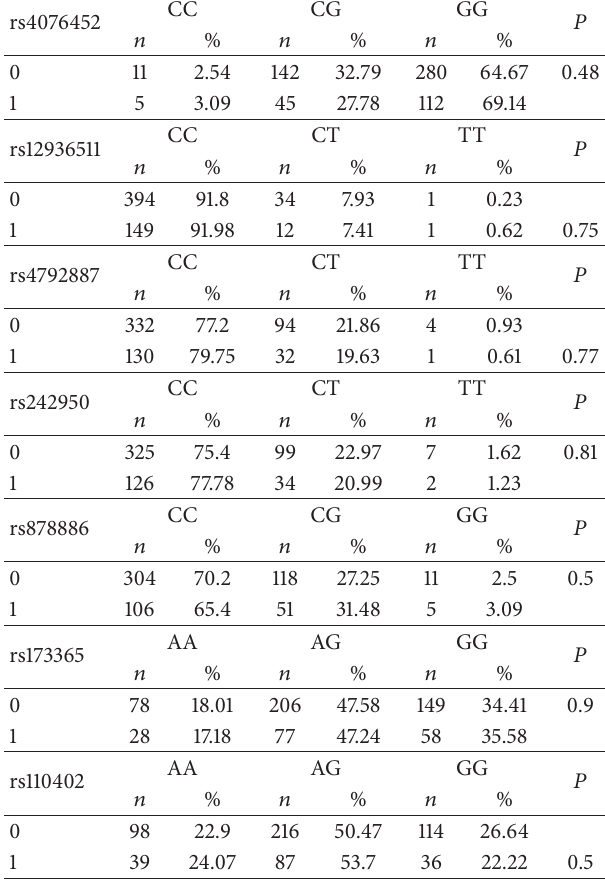
Table 3: Polymorphisms of CRHR1 gene (genotypes).